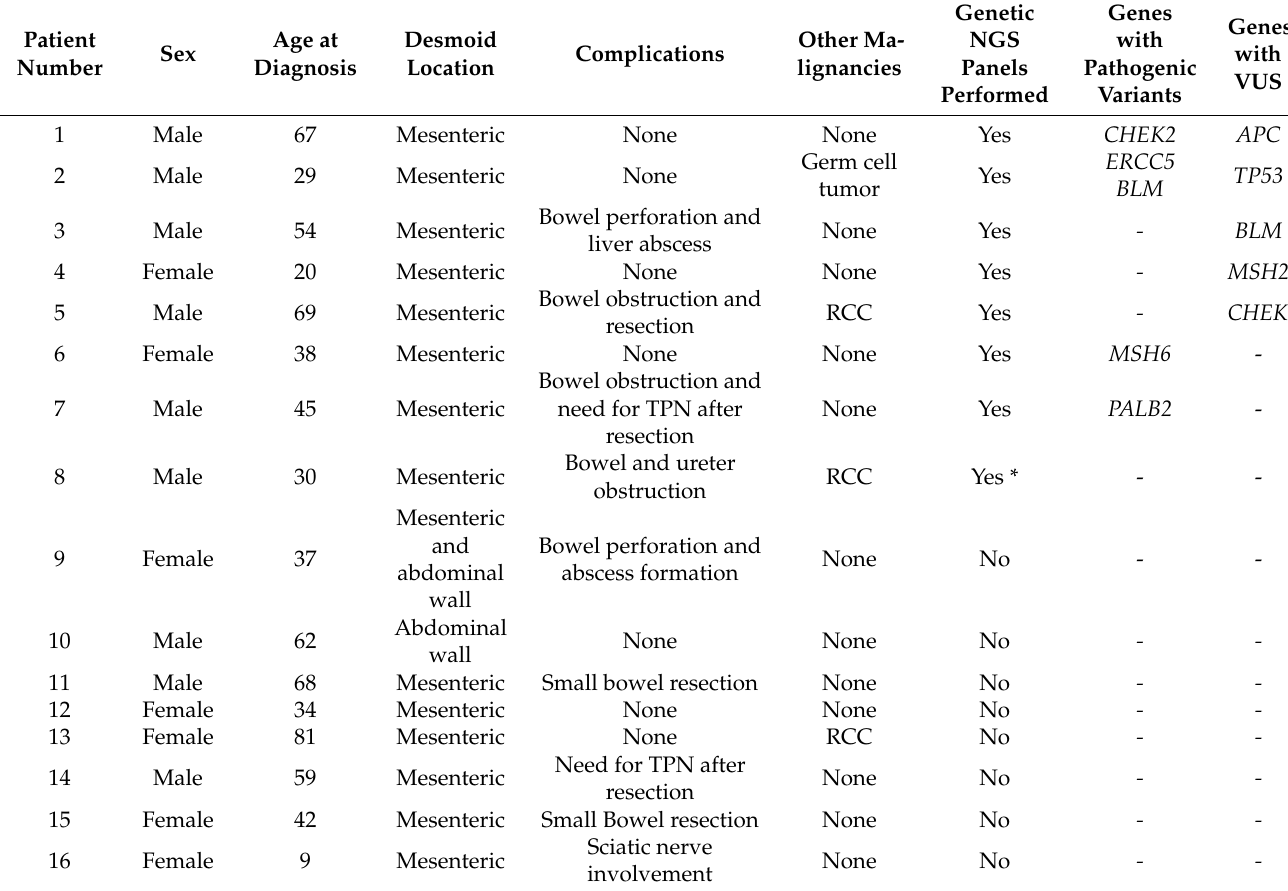
Table 2. Characteristics of non-FAP desmoid patients and their genetic